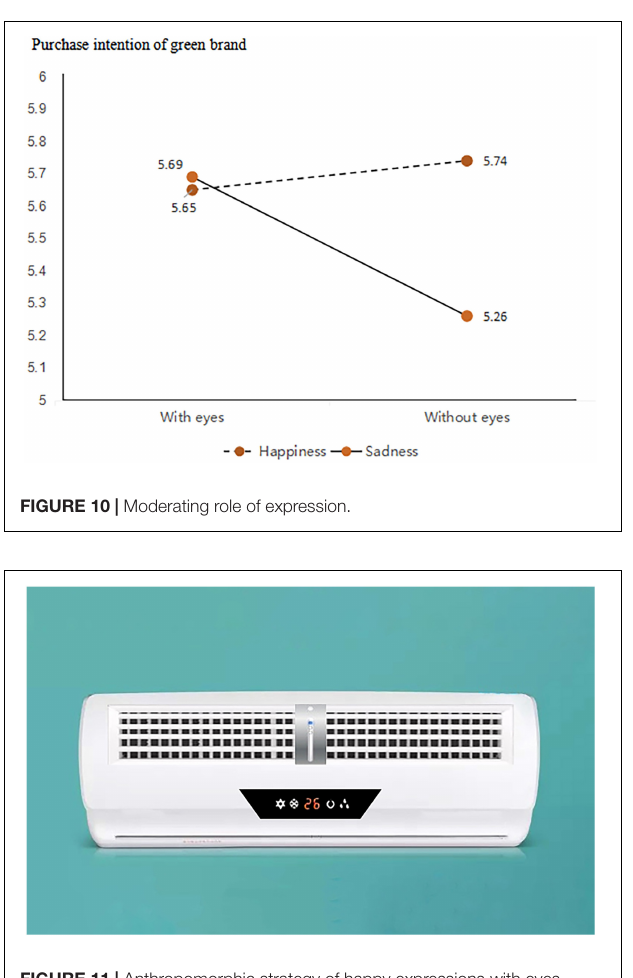
FIGURE 11 | Anthropomorphic strategy of happy expressions with eyes.